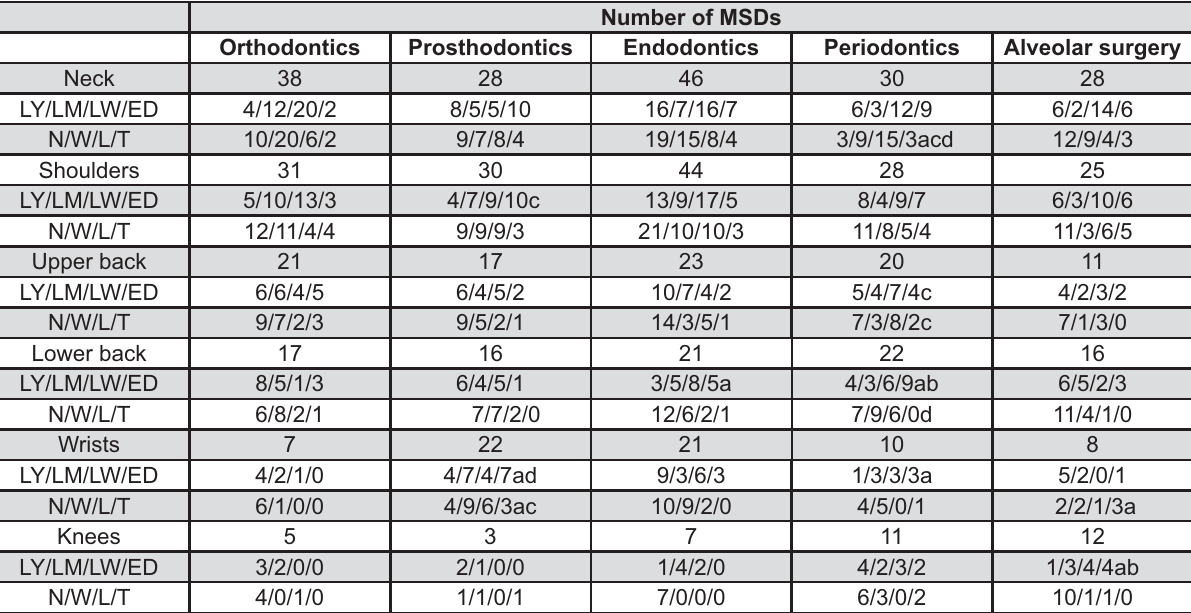
Figure 3- Frequency and impact of Musculoskeletal disorders (MSDs) in different dental specialties The frequencies were categorized as "everyday" (ED), at least once in the "last week" (LW), "last month" (LM) or "last year”